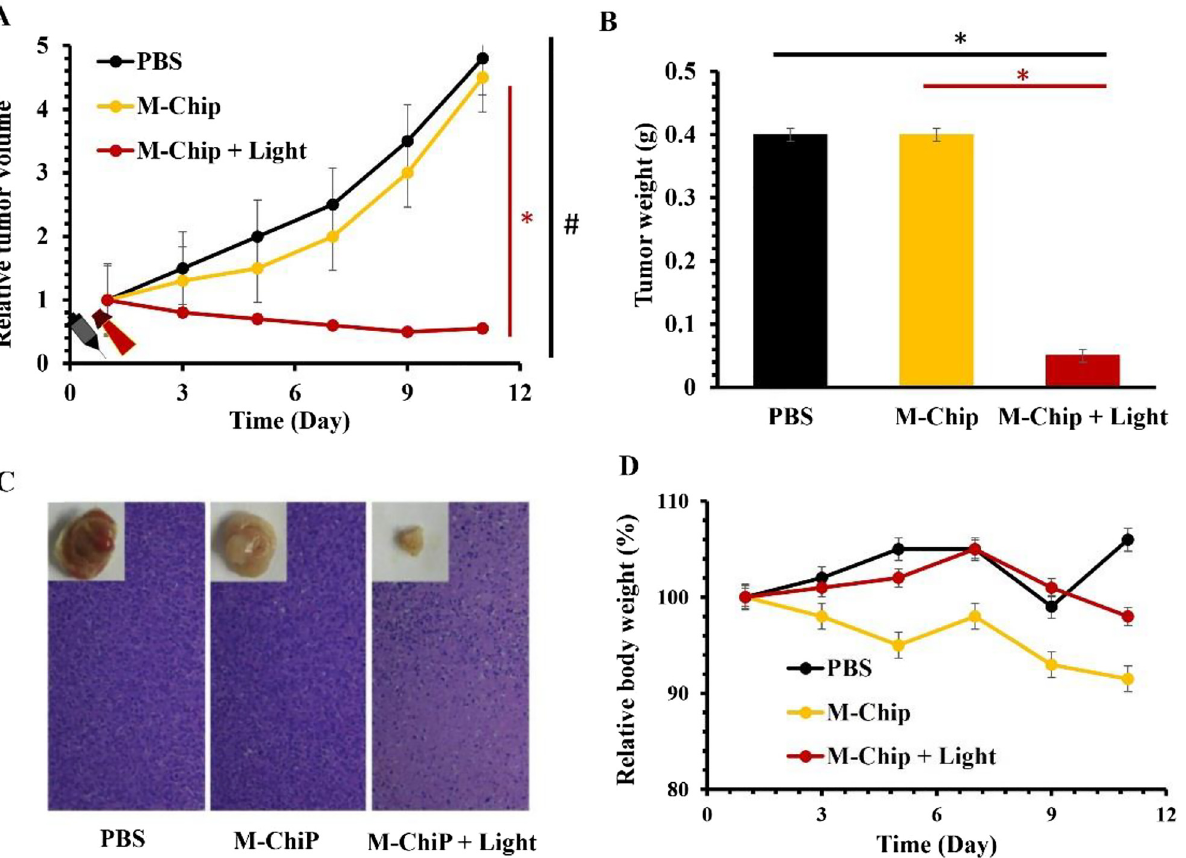
Figure 39: Antitumor study of M-Chip. (A)TherelativetumorvolumechangesaftertreatmentwithPBS,M-Chip(200µL,1.2mgmL − 1 ),andlaserirradiation(150Jcm − 2 ,250mWcm − 2 for 10min).(B)Thecorrespondingaveragetumorweightand(C)thescari fi edtumorimagesandHEstaininganalysisoftumortissuesaftervarious treatments at the 11th day. (D) The relative body of the mice after various treatments in 11 days. Adapted from Cheng et al. [93].